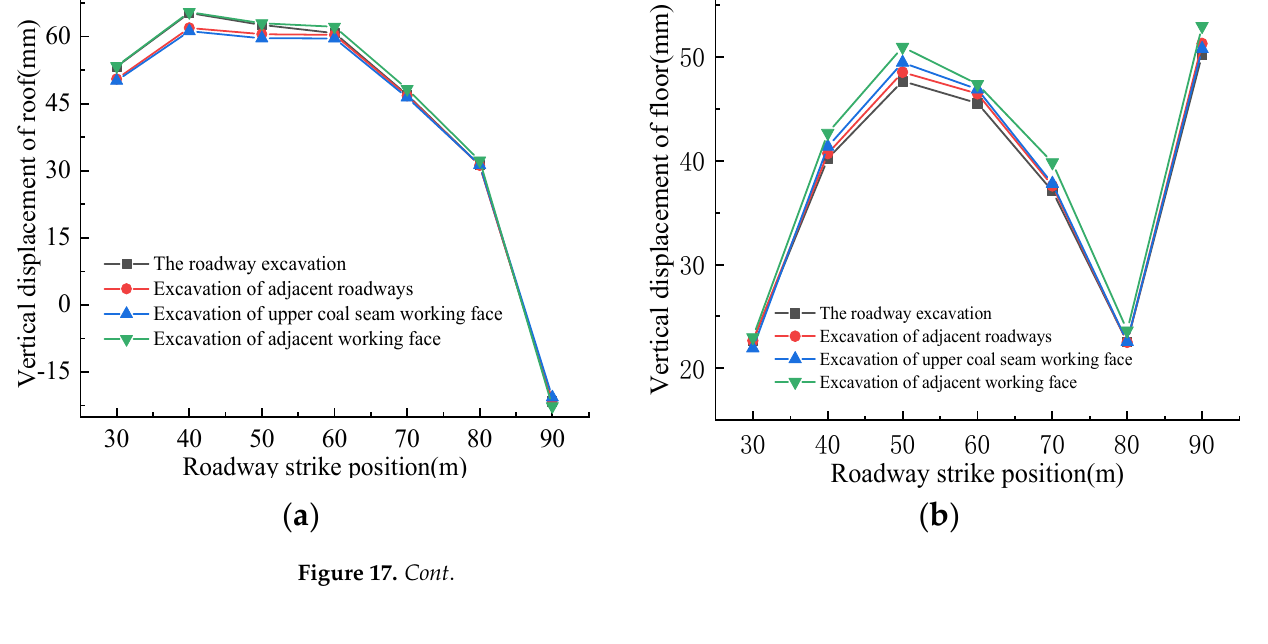
Figure 16. Influence of excavation disturbance on this roadway. Figure 17 illustrates the variation of horizontal displacement of the roadway along with the strike position. Under the repeated mining, the deformation of surrounding rock in the roadway increases with the increase of mining times, especially for the coal pillar side. The deformation variables of the two sides are prone to have asymmetric situations during the mining process, and the stability maintenance of the coal pillar side needs to be emphasized.